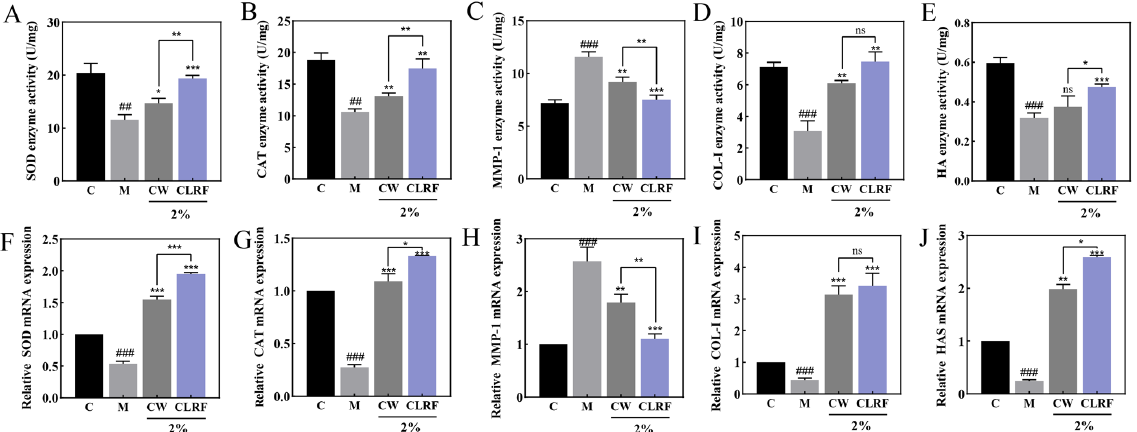
Figure 4. Effects of CLRF and CW on HSF antioxidant enzyme and protein hydrolase content: Effects of CLRF and CW on SOD content ( A ) and its gene expression ( F ); Effects of CLRF and CW on CAT content ( B ) and its gene expression ( G ); Effects of CLRF and CW on MMP-1 activity ( C ) and its gene expression ( H ); Effects of CLRF and CW on COL-I content ( D ) and its gene expression ( I ); Effects of CLRF and CW on HA content ( E ) and HAS 1 gene expression ( J ). CW: Coix seed water extract; CLRF: Coix seed Lactobacillus reuteri fermentation broth; C: control group; M: H 2 O 2 damage model group. Each value is expressed as mean ± SD ( n = 3). (*: p < 0.05, **: p < 0.01, ***: p < 0.001, ns > 0.05, versus model group, ##: p < 0.01, ###: p < 0.001, versus control group).